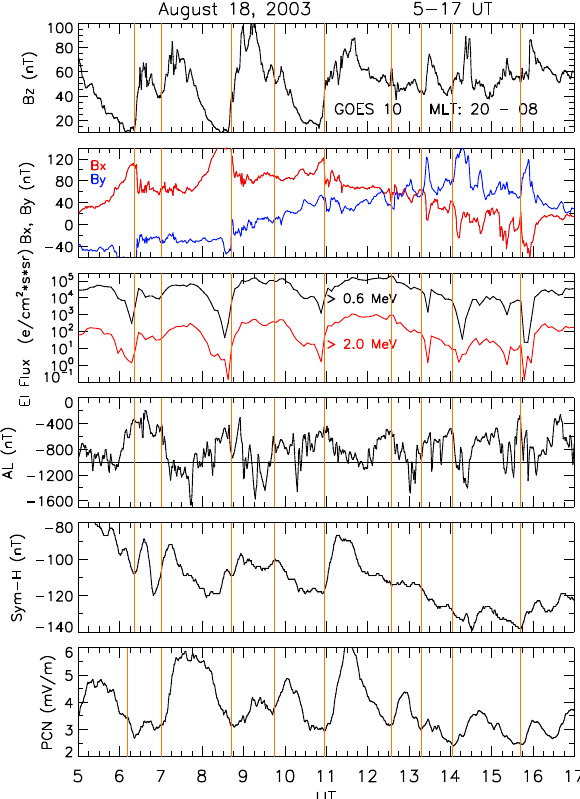
Fig. 10. GOES-10 field and plasma data (first three panels) and magnetic indices AL, SYM-H and PCN for the interval 05:00– 17:00UT. Panels 1 and 2 show GOES magnetic field components B z (black in top panel), B x (red), B y (blue) at geosynchronous altitude, when the spacecraft moved from evening (20:00MLT; 05:00UT) through midnight (24:00MLT; 09:00UT) to the morning sector (08:00MLT; 17:00UT). Panel three shows high-energy elec- tron differential fluxes. Vertical guidelines illustrate the association between GOES-10 magnetic field events and PCN